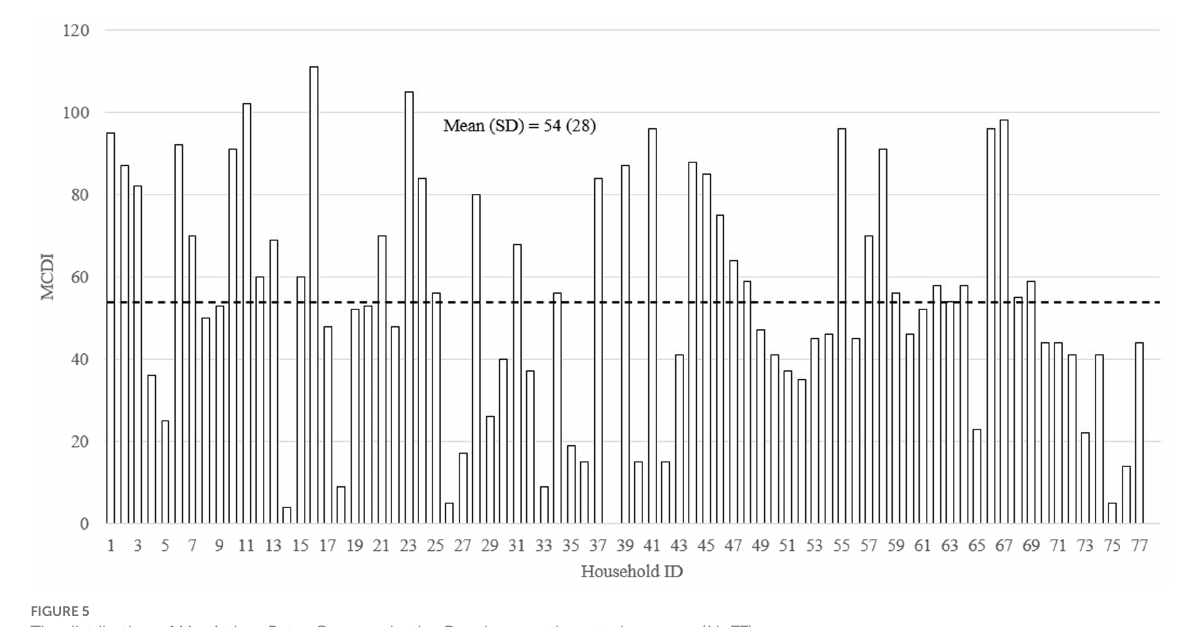
FIGURE 5 The distribution of MacArthur-Bates Communicative Development Inventories scores ( N = 77).